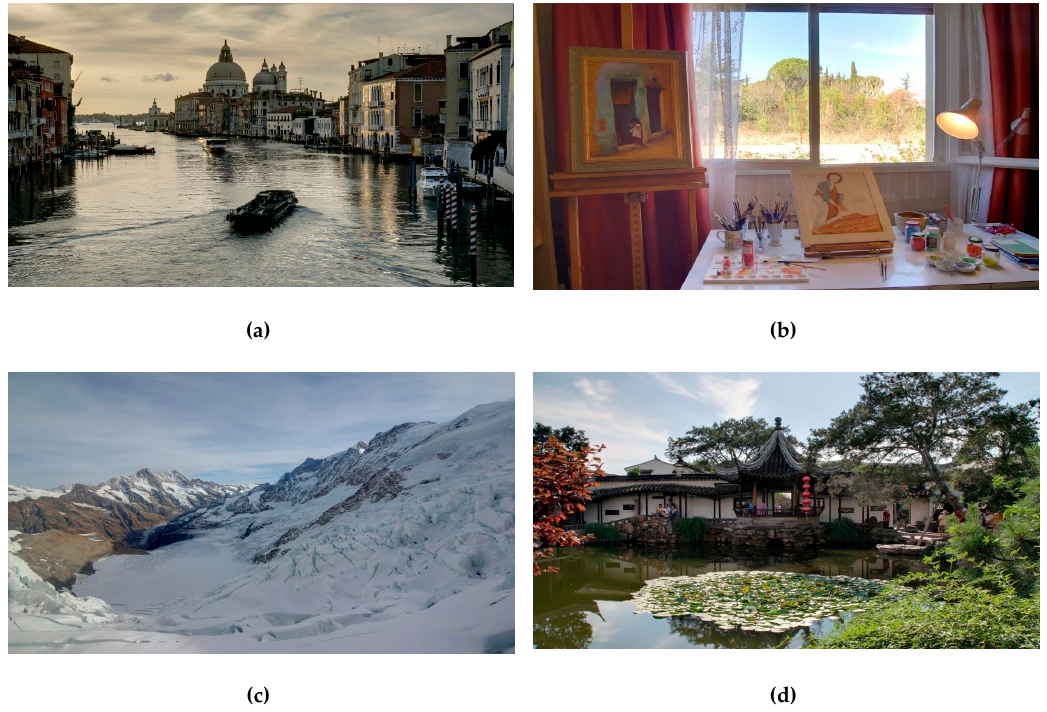
Figure 10. Results of the proposed method using the remaining test images. ( a ) Result of the test image Grand Canal. ( b ) Result of the test image Studio. ( c ) Result of the test image Mountains. ( d ) Result of the test image Chinese Garden.